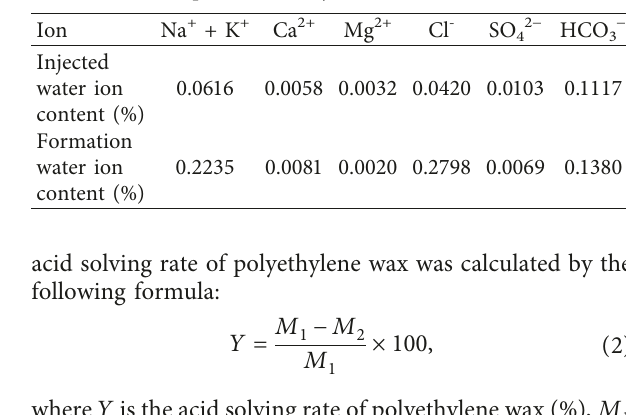
Table 1: Ion compositions of injected water and formation